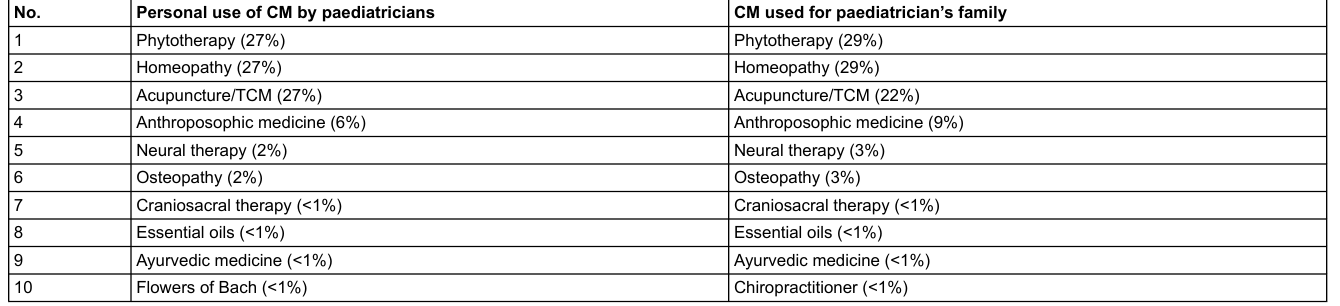
Table 2: Complementary medicine (CM) methods used by paediatricians and their immediate families (percentage of all responses). No. Personal use of CM by paediatricians CM used for paediatrician’s